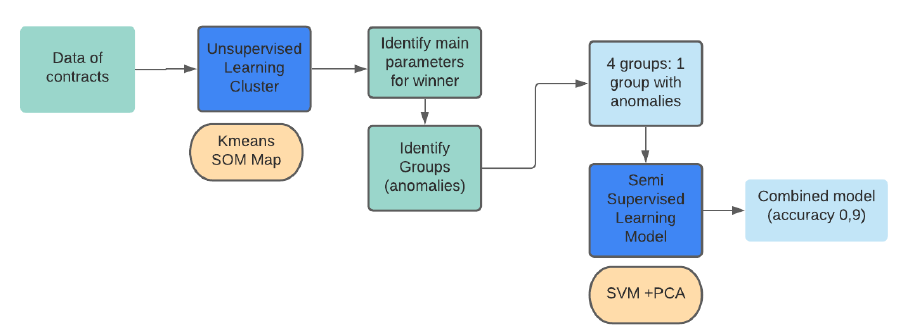
Figure 3. Detailing two main phases that composed the